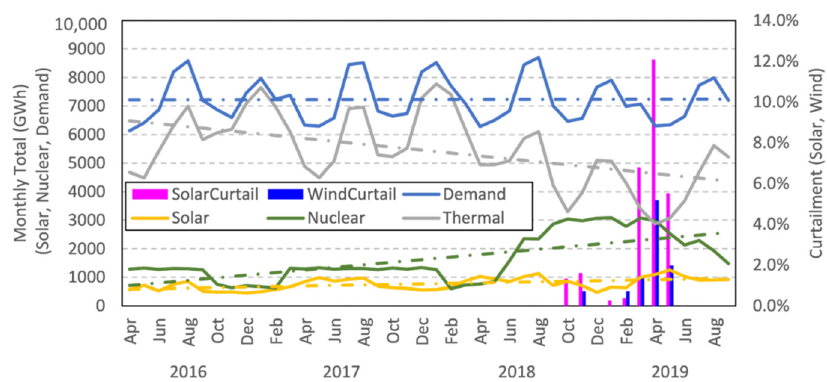
Figure 3. Main factors influencing curtailment in Kyushu from April 2016 to September 2019.